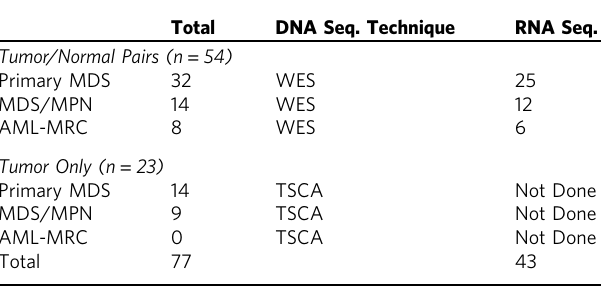
Table 1 Characteristics of the Pediatric MDS Cohort Total DNA Seq. Technique RNA